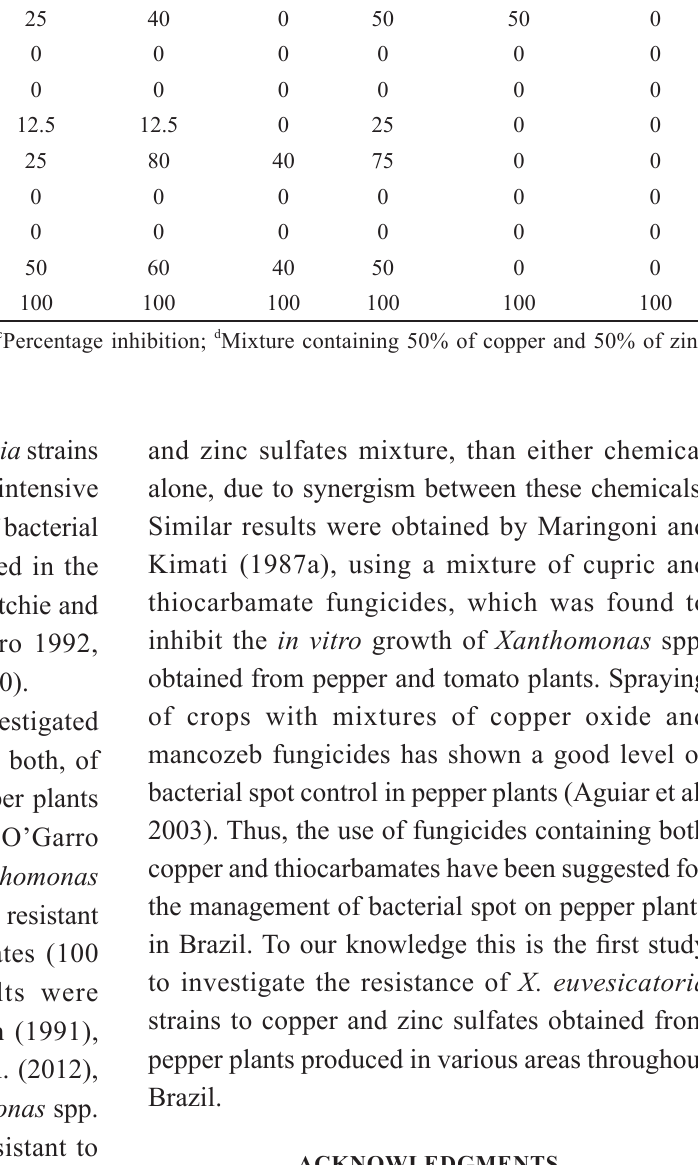
In vitro inhibition of Xanthomonas euvesicatoria strains from several locations in Brazil to copper sulfate, zinc sulfate and a mixture of copper and zinc sulfates.